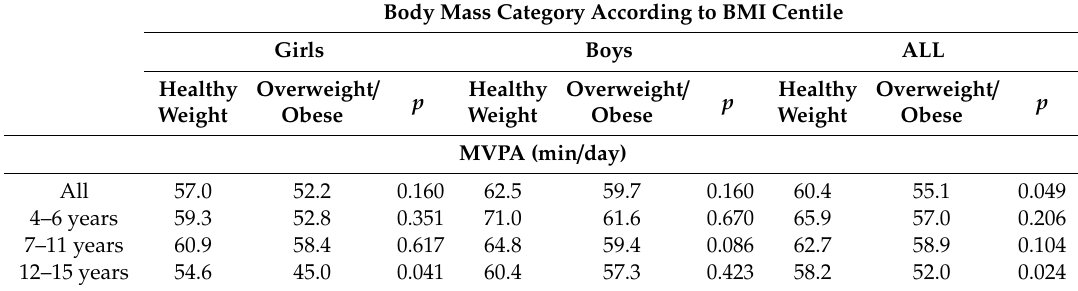
Table 3. The relationship between time spent in MVPA and bodyweight category (dichotomous division) taking into account the sex and age of the